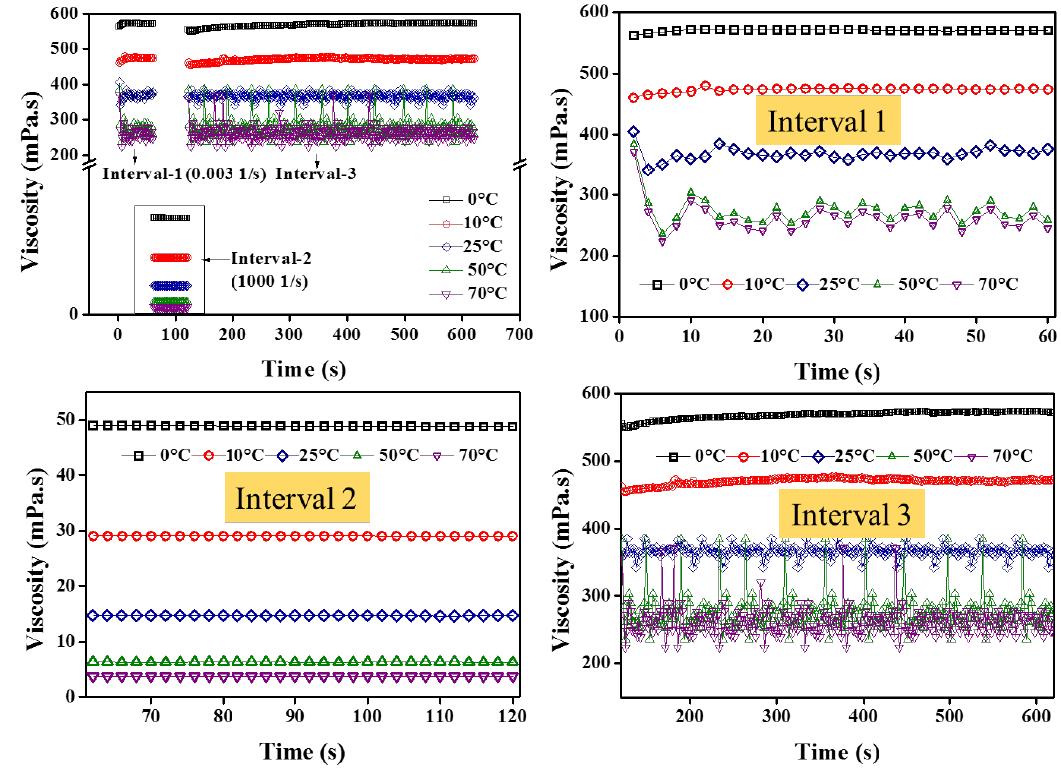
Figure 14. Three intervals thixotropic test (3ITT) for NF1.